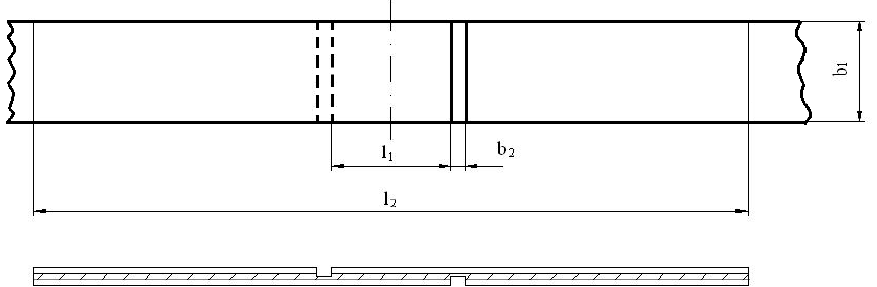
Figure 2. Shape and dimensions of strength test sample for 3 ply veneer plywood (l 1 —shear length (25 ± 0.5 mm); b 1 —shear width (25 ± 0.5 mm); b 2 —saw cut width (2.5 to 4 mm); l 2 —minimum distance between the clamps (50 mm).